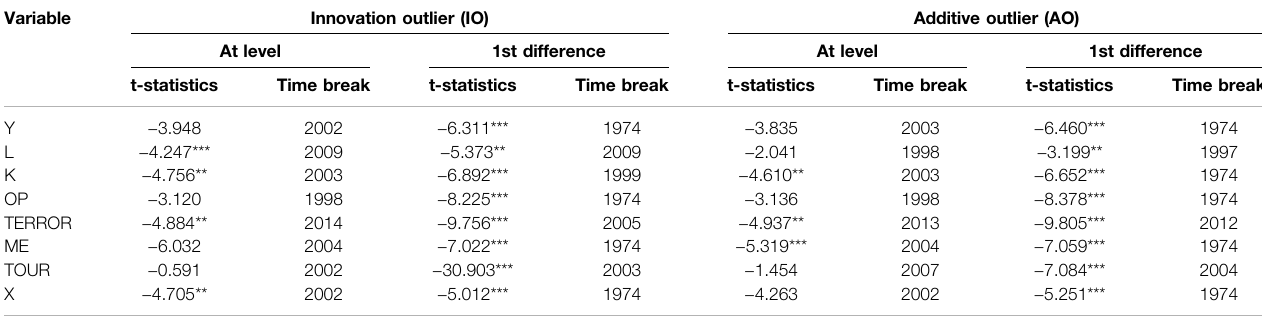
TABLE 3 | Clemente – Montanes – Reyes unit root analysis with